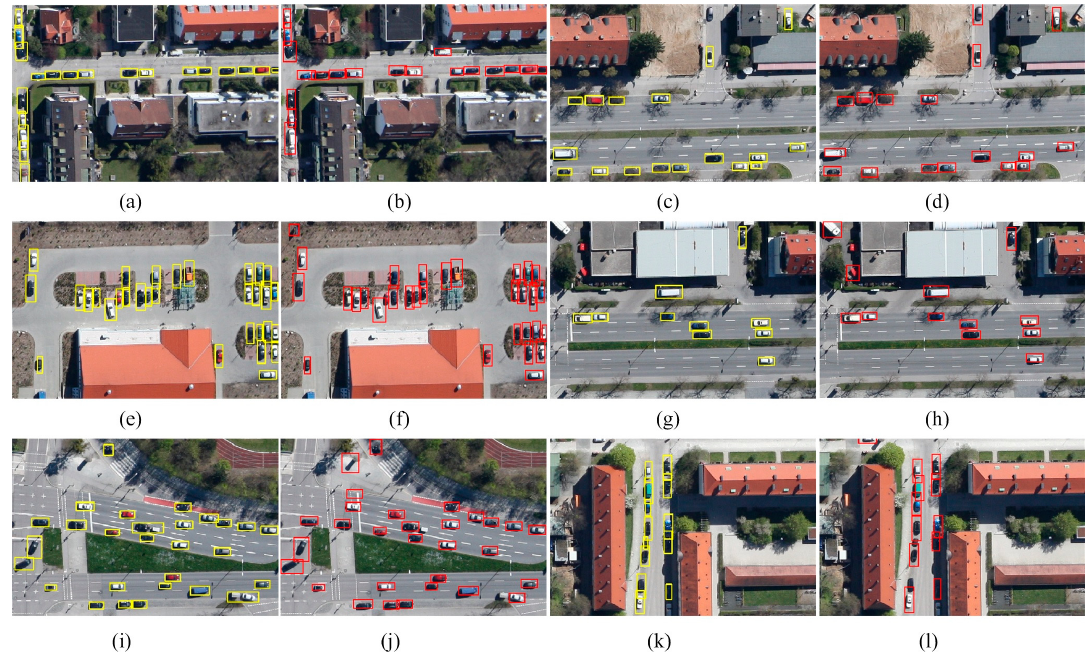
Figure 11. ( a – l ) some detection examples of VEDAI dataset.